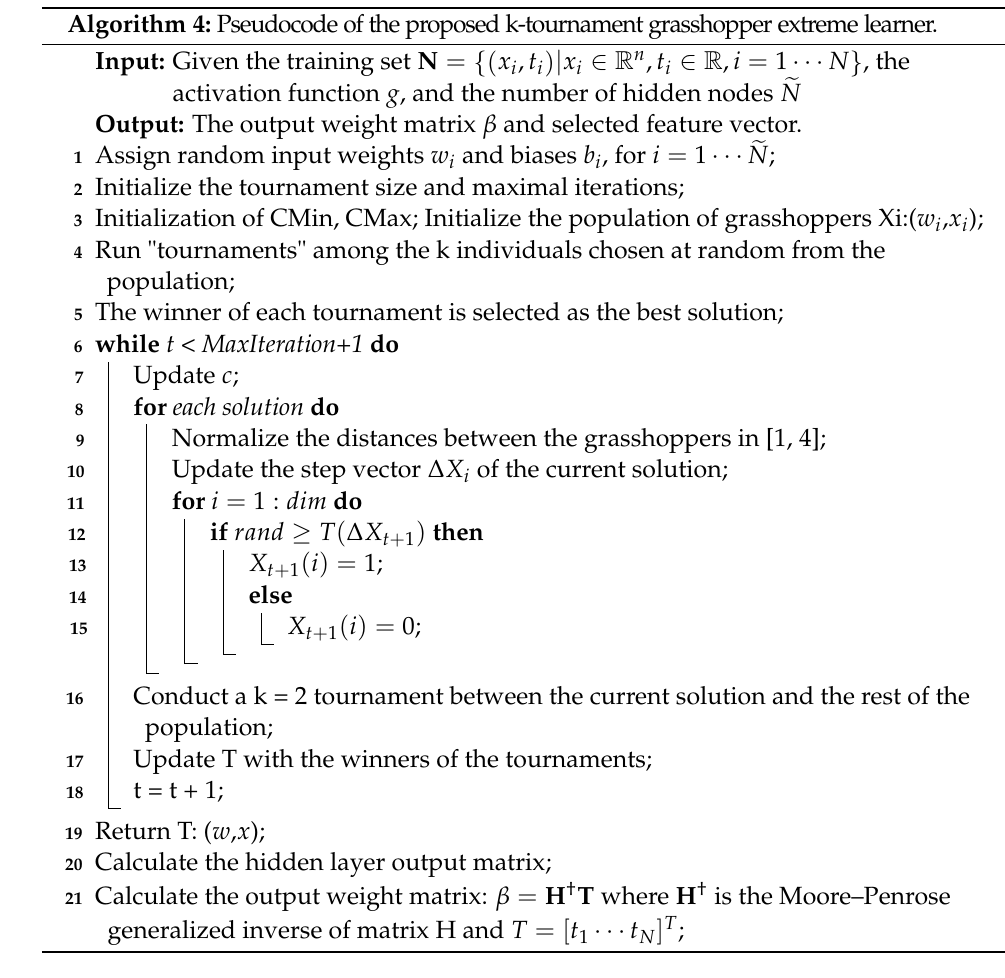
Algorithm 4: Pseudocode of the proposed k-tournament grasshopper extreme